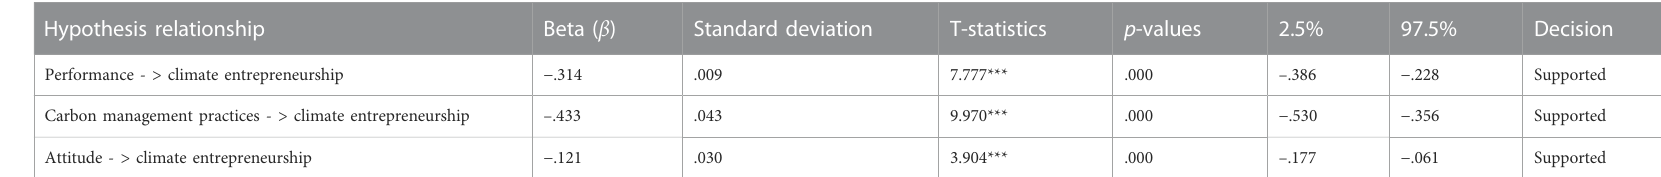
TABLE 3 Path coef fi